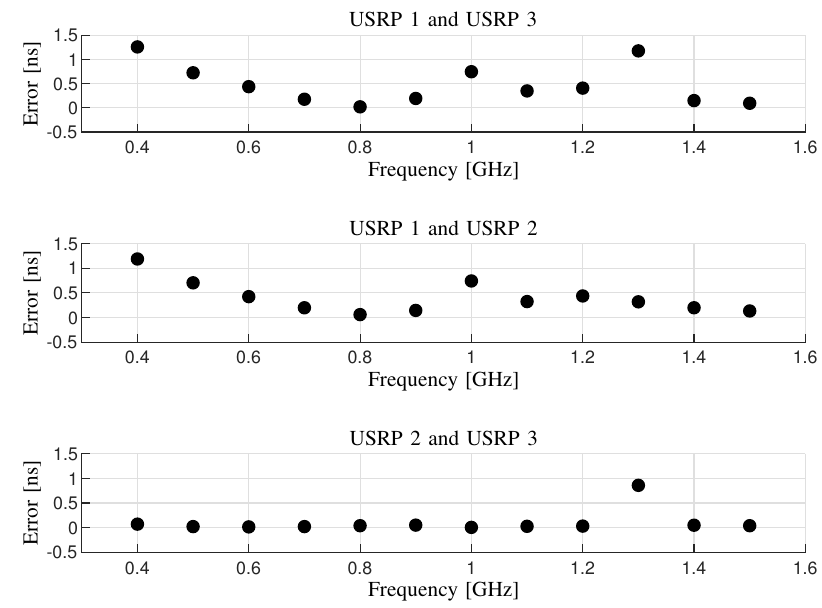
Figure 5. The time synchronization errors among the USRPs versus the frequency tested using the